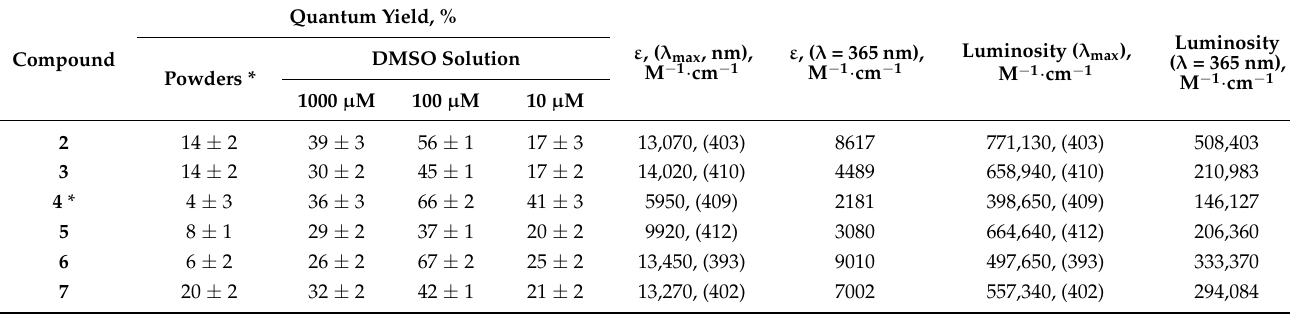
Table 4. Photophysical properties of compounds 2 – 7